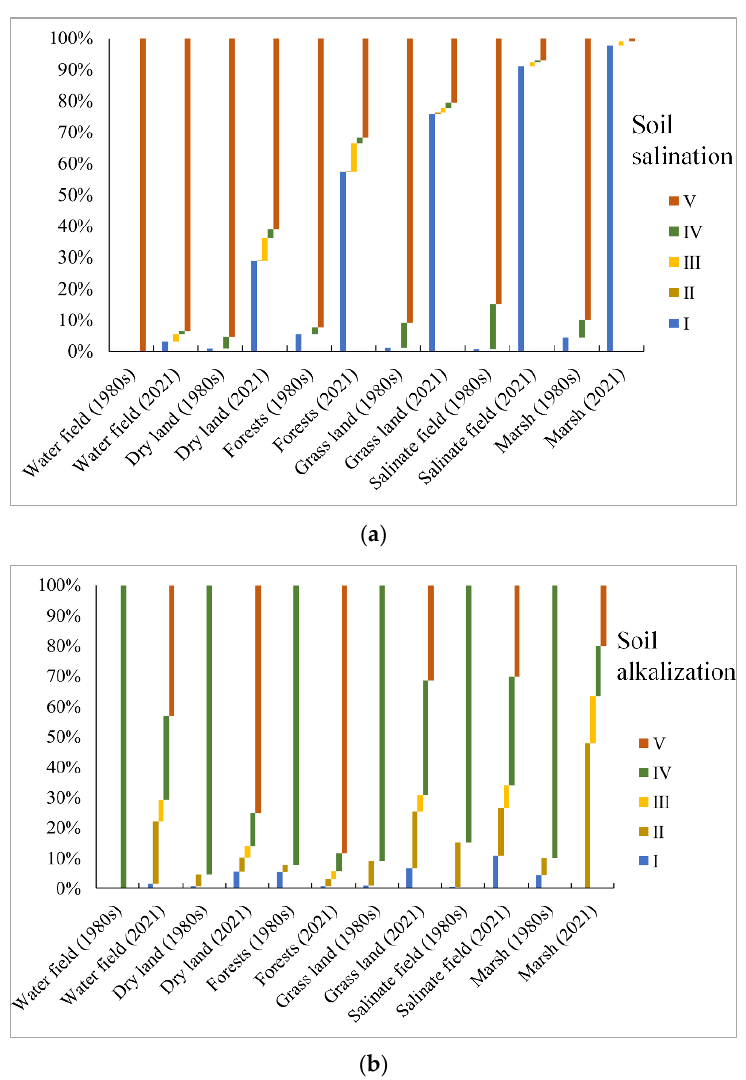
Figure 7. Percentage of soil salinization ( a ) and alkalization ( b ) under different main land-use types in the 1980s and 2021. in the 1980s and